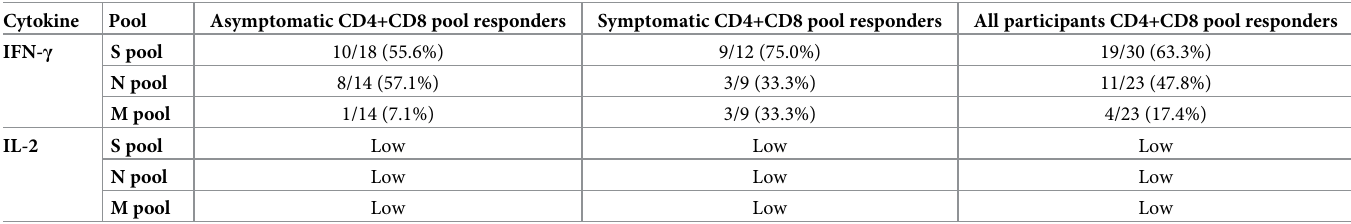
The numbers and percent positive of asymptomatic and symptomatic participants with positive IFN- γ or IL2 responses post-infection to the CD4+CD8 pool were compared in matched participants with responses to the individual S, N, or M pools. Low responders had activities that did not meet the positivity criteria